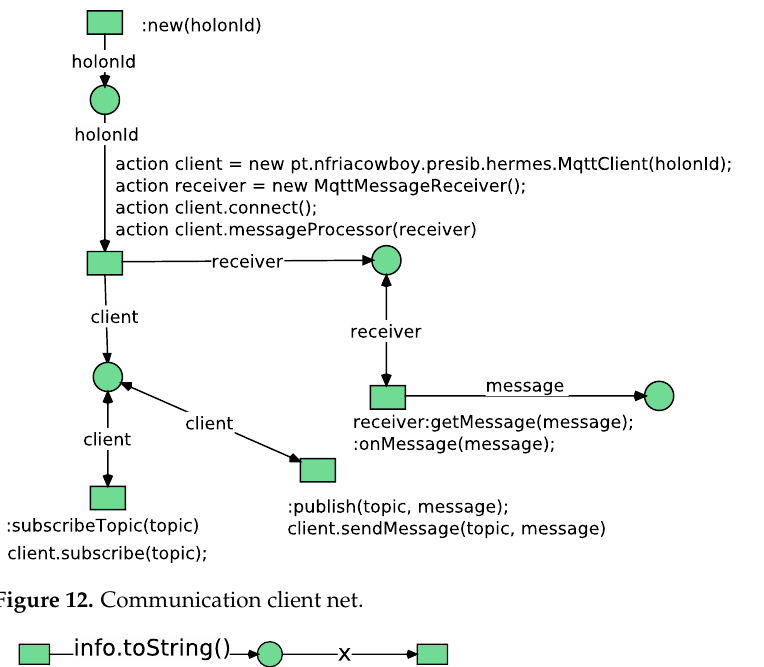
Figure 13. Usage of the observer in a Net